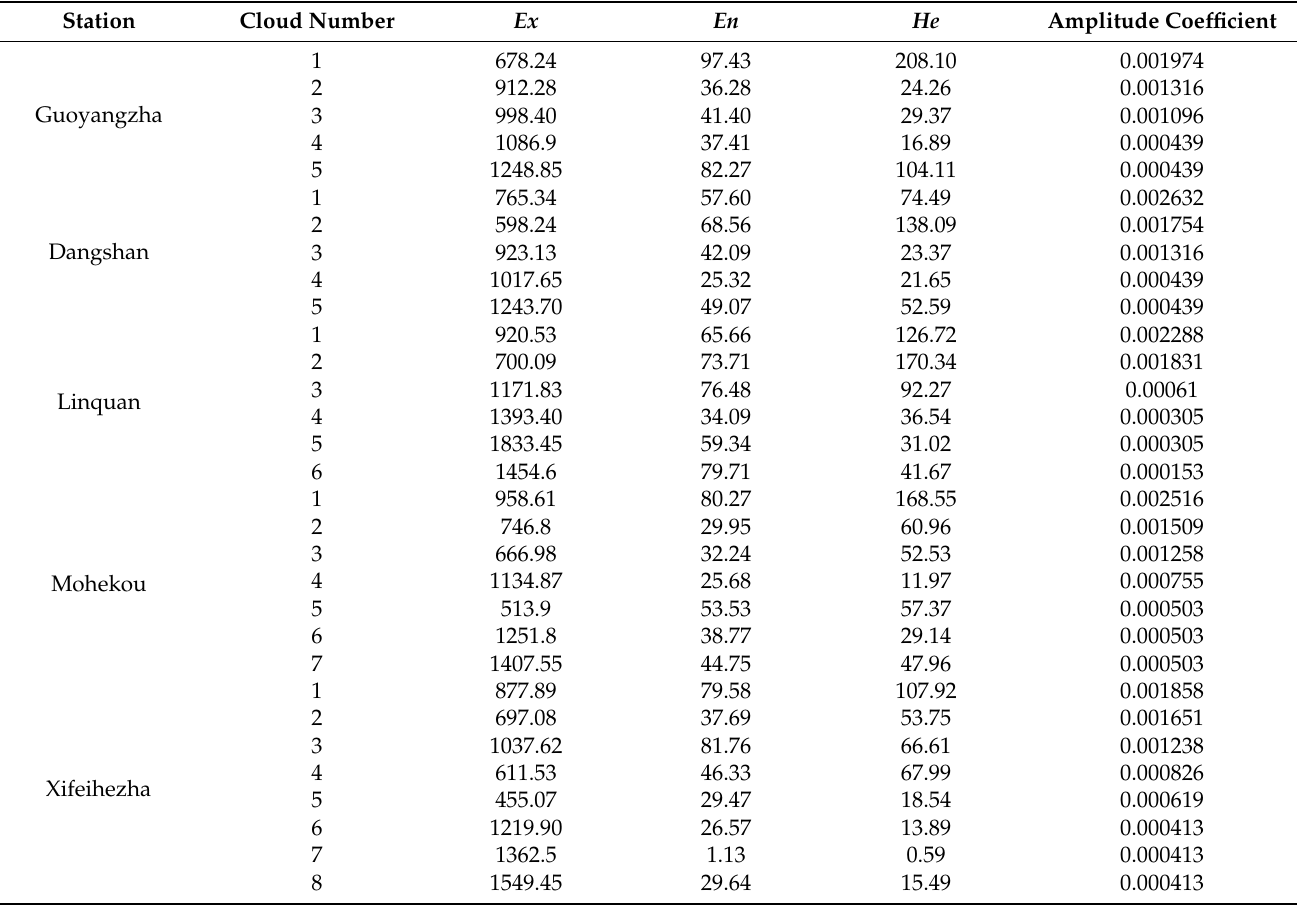
Table 1. Cloud characteristics of normal conceptual clouds in northern Anhui province, China. Station Cloud Number Ex En He Amplitude